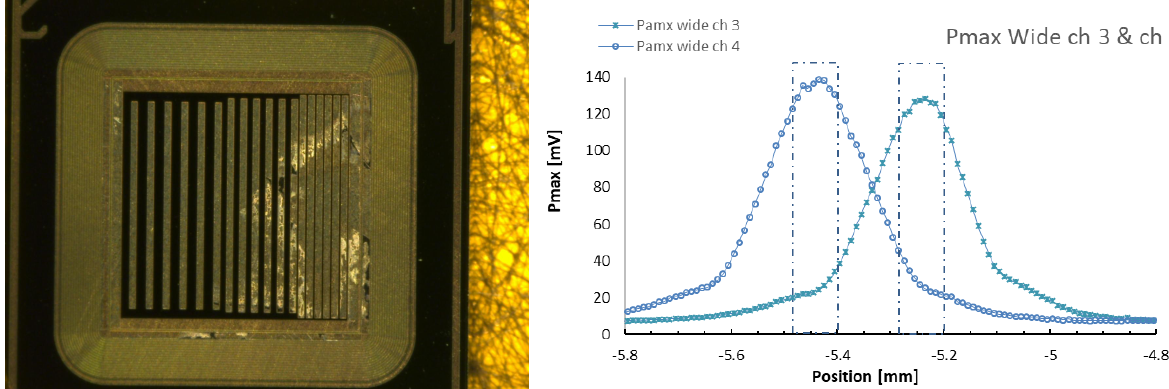
Figure 4. ( Left ): Prototype BNL AC-LGAD strip sensor. ( Right ): response (pulse maximum) of two strips as a function of position (perpendicular to the strip) of a sensor with 200 µ m of pitch [31]. The dashed lines highlight the position of the two strips in the plot. Data taken at the FNAL test beam